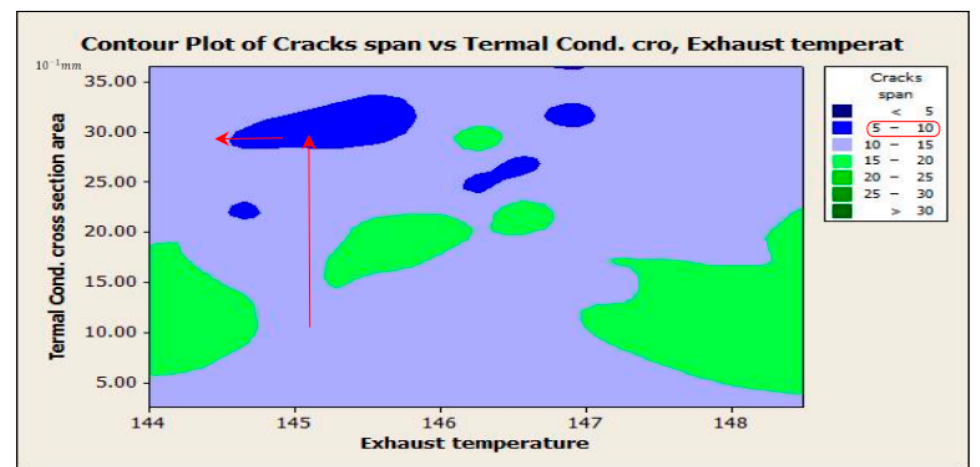
Figure 14. The strip cross section according to the intake affects the electrical conductivity at the points to the highest available level. Hint: points to the preferred significant values.